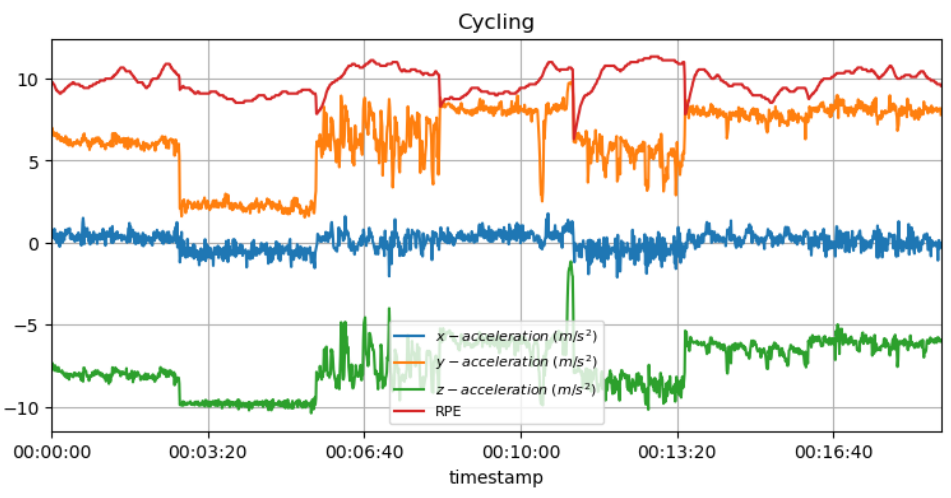
Figure 15. RPE for cycling activity with acceleration data.